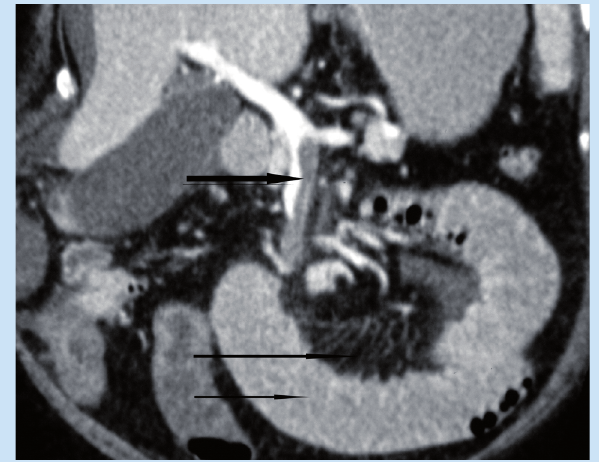
Fig. 2. The porto-venous phase of a contrast-enhanced reconstructed coronal CT study. The SMV thrombosis is extending up to the conflu- ence with the splenic vein. The top arrow indicates the thrombosis. Note the mesenteric congestion (middle arrow) and the dilated bowel (bottom arrow).